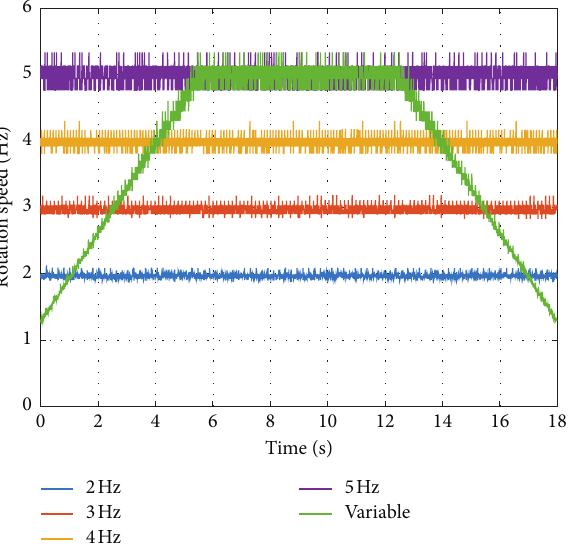
Figure 10: 5 speed conditions.